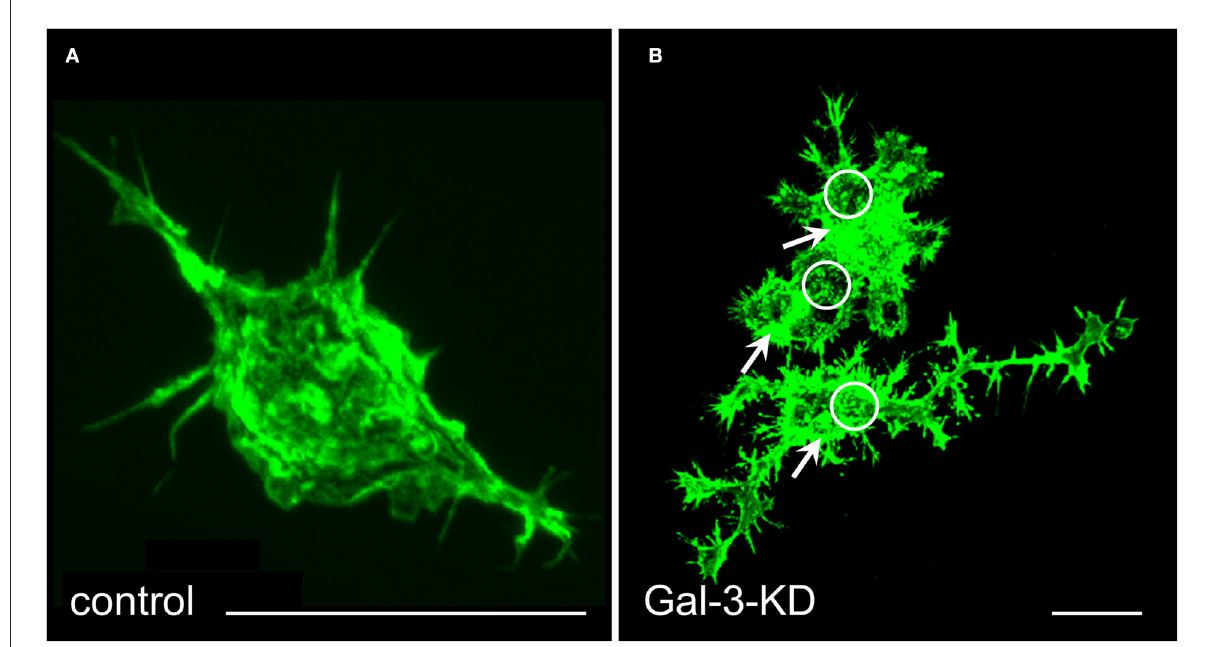
FIGURE3 Gal-3/MAC-2 knocked-down (KD) microglia display branched-like morphology and organization of actin in dense punctate and massive deposits whereas control microglia display amoeboid-like morphology and organization of actin in filamentous structures. Immunofluorescence confocal microscopy images of (A) control microglia and (B) Gal-3-KD microglia; dense punctate and massive deposits of F-actin are respectively marked by circles and arrows. Alexa Fluor 488 labeled phalloidin (green) visualizes F-actin. Knocking down Gal-3 protein expression was achieved through lentiviral infection of wild-type microglia with shRNA directed against Gal-3/MAC-2 mRNA. As a control, wild-type microglia were infected in a similar way with the shRNA against the non-target firefly Luciferase gene. As seen, the image of control microglia in (A) is enlarged by a factor of 4 compared with the image of the Gal-3-KD microglia in (B) . Bars: 5 µ m in (A) and 20 µ m in (B) . Modified after Reichert and Rotshenker